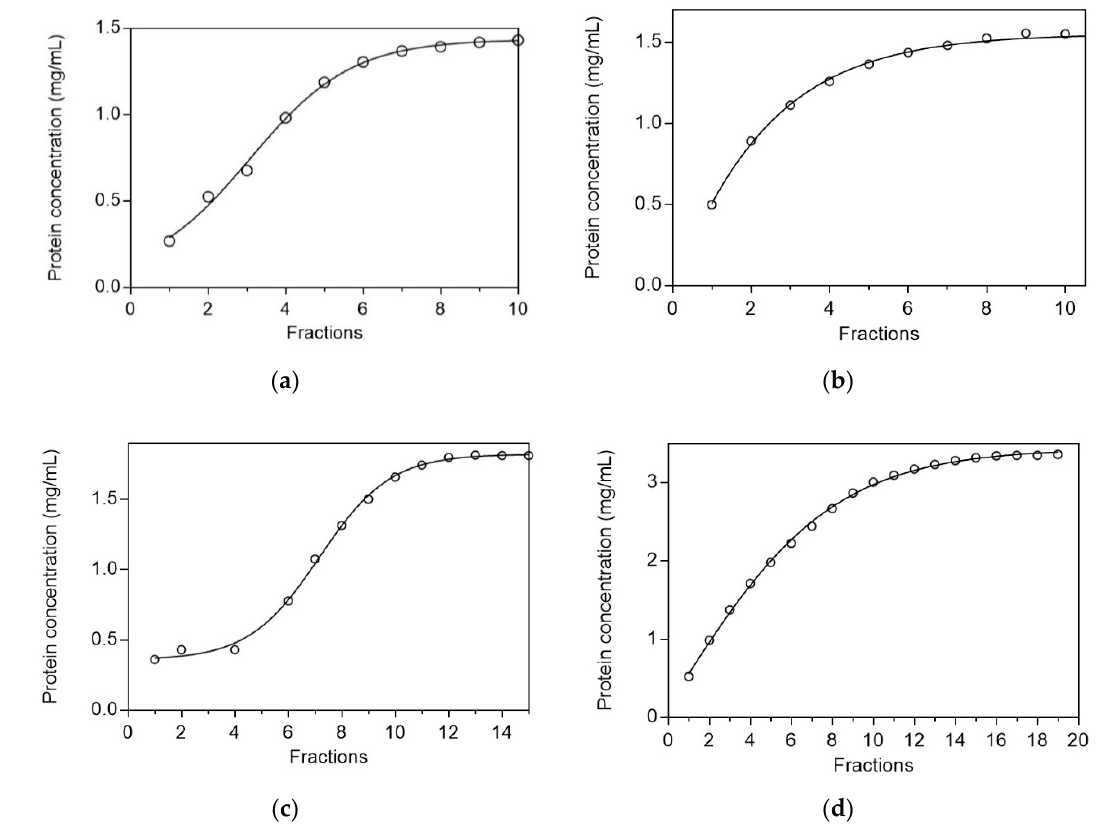
Figure 3. Dynamic capacity of bovine serum albumin (BSA) and lysozyme (LYS) on the affinity adsorbents CB3GA-Cellulose-1 and CB3GA-Cellulose-2. ( a ) Dynamic capacity determination of BSA for CB3GA-Cellulose-1. ( b ) Dynamic absorption capacity determination of LYS for CB3GA-Cellulose-1. ( c ) Dynamic capacity determination of BSA for CB3GA-Cellulose-2. ( d ) Dynamic absorption capacity determination of LYS for CB3GA-Cellulose-2. Eluted fractions (2 mL) were collected and total protein was determined by the Bradford method [28].